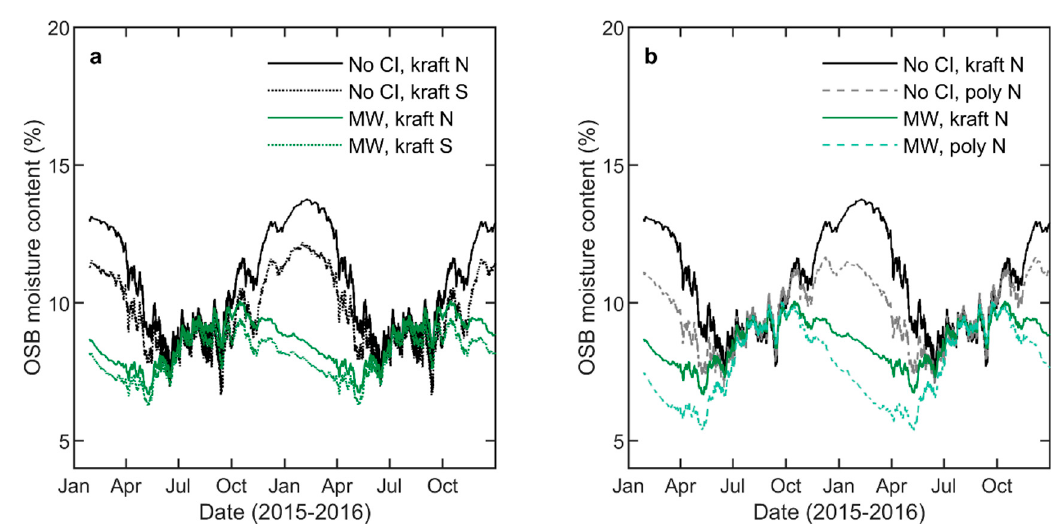
Figure 3. Simulated moisture content of OSB in select design wall cases. ( a ) Comparison between North and South facing walls, ( b ) comparison between kraft and poly vapor barrier.